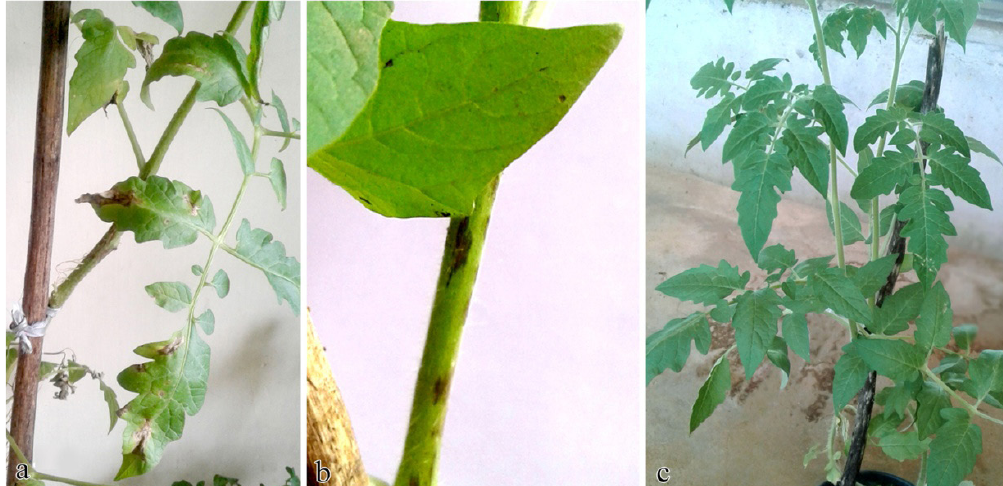
Figure 4 : Target spot symptoms development on a) leaves and b) stem inoculated with C. cassiicola isolate TS1 and c) control